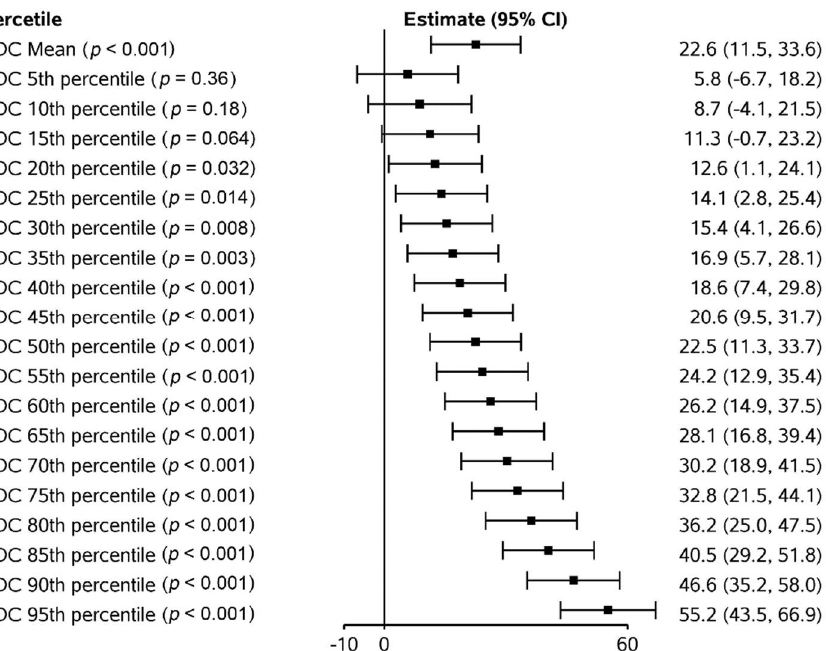
Figure 4. Average change in apparent diffusion coefficient (ADC) values for primary tumour adjusted for pre-treatment ADC.